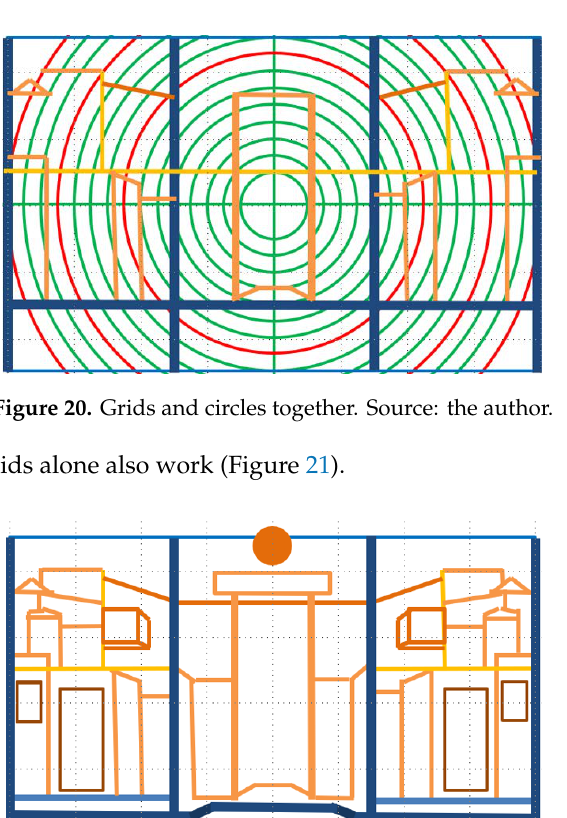
Figure 21. Grid only. Source: the author.